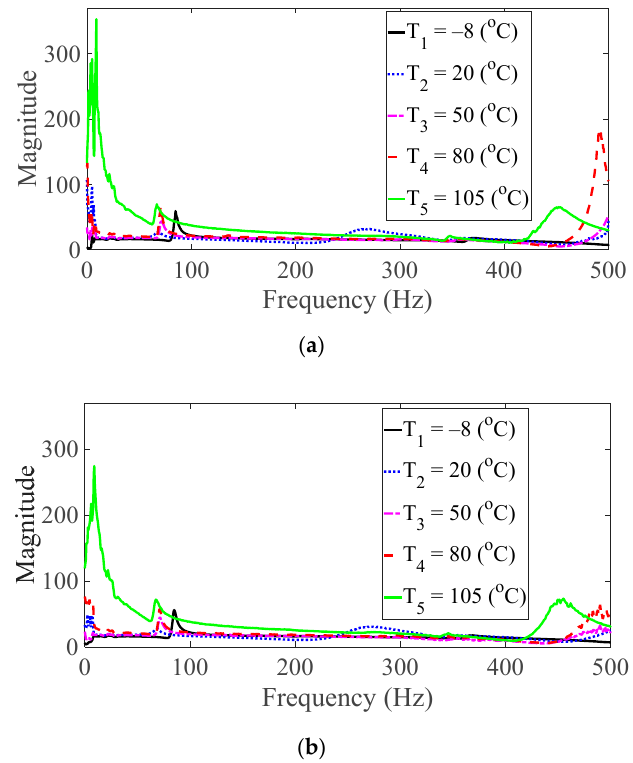
Figure 8. Measured FRFs with θ = 60°: ( a ) p = harmonic and ( b ) p = random.